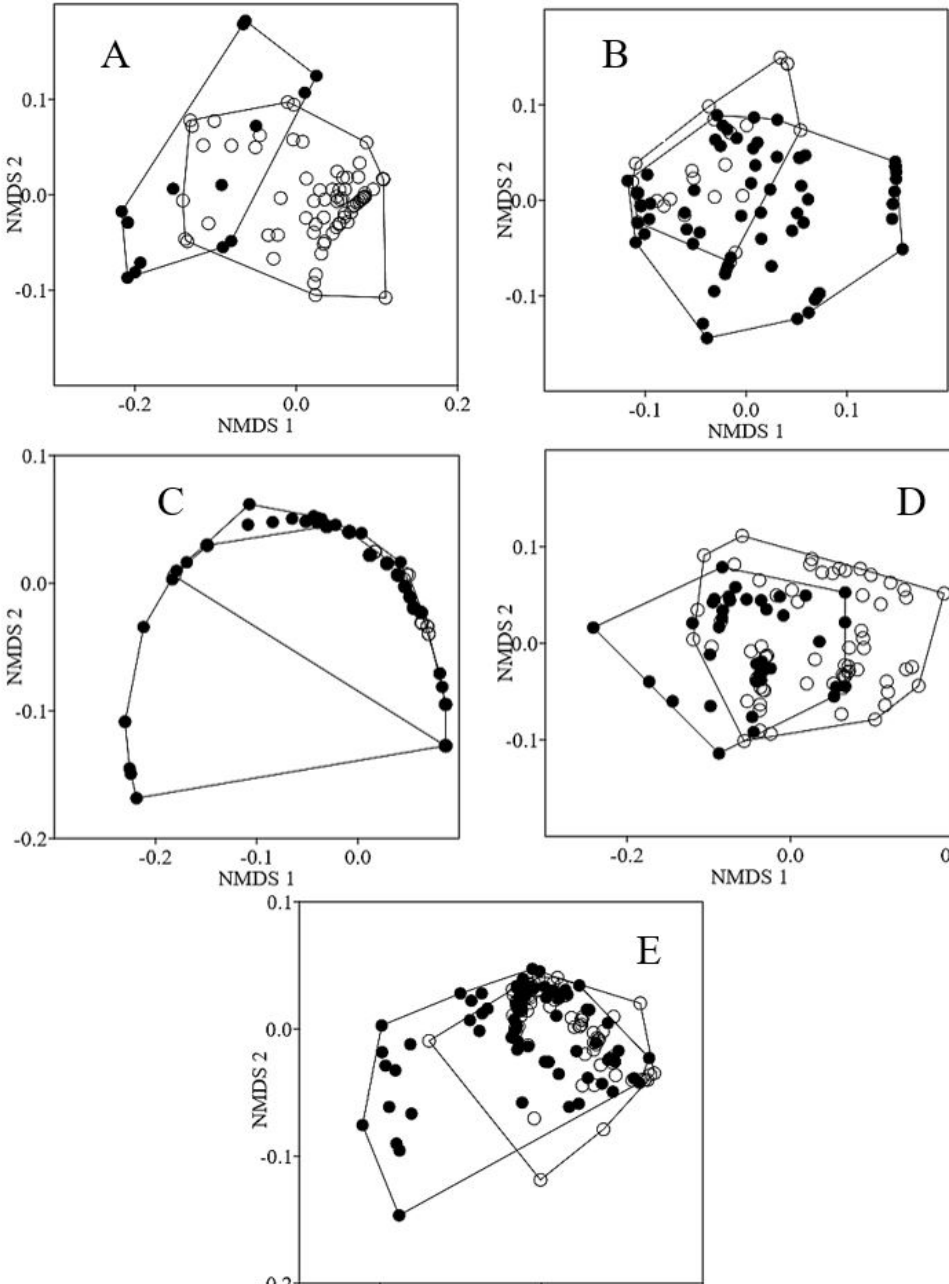
Figure 4. Graphical representation of the first two axes of the NMDS, showing the variation in the consumption of food resources of the studied fish species, - before and after the biomanipulation experiment, at the Estação